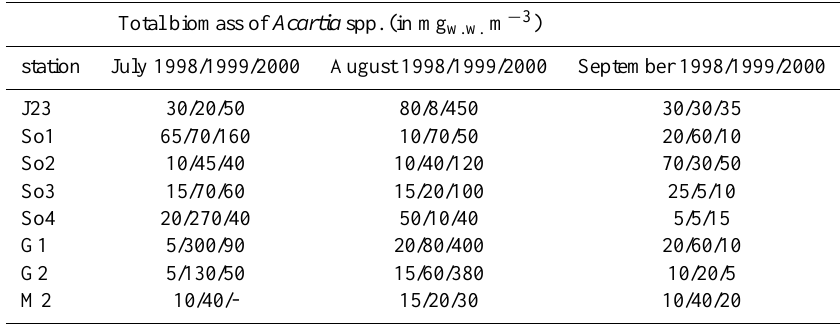
Table 2. Total biomass of Acartia spp. (in mg w . w . m − 3 ) as monthly averages in the surface (0–20m) layer in the summer season (July, August, September) in 1998, 1999 and 2000 from the eight stations in the Gdansk Gulf (see Mudrak, 2004). Total biomass of Acartia spp. (in mg w . w . m − 3